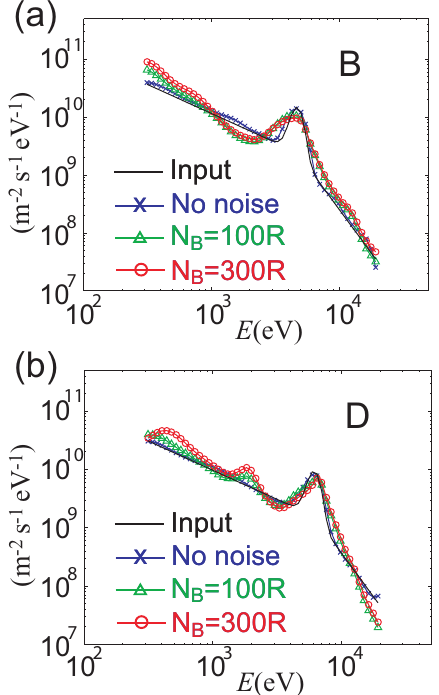
Fig. 6. Differential flux of the incident electrons reconstructed from only auroral images. (a) and (b) show the results for points B and D in Fig. 3a, respectively. Black and blue curves represent the differential flux of the original incident electrons and the differen- tial flux reconstructed from auroral images with no noise, respec- tively. Green and red curves correspond to the differential flux re- constructed from images with a background noise of 100 and 300R,